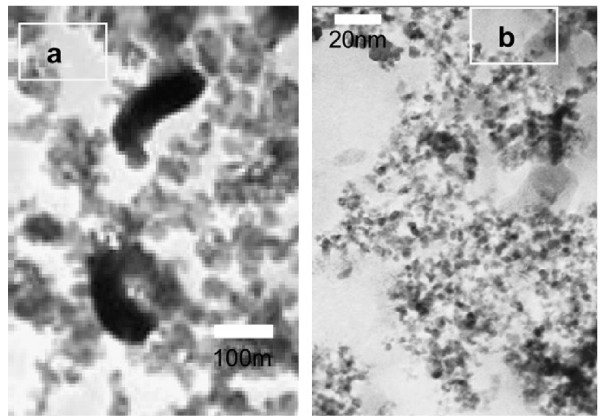
TEM micrographs of PSMA-γ-APS-TiO2 hybrid nanocomposites. (a) Low and (b) high magnifications.